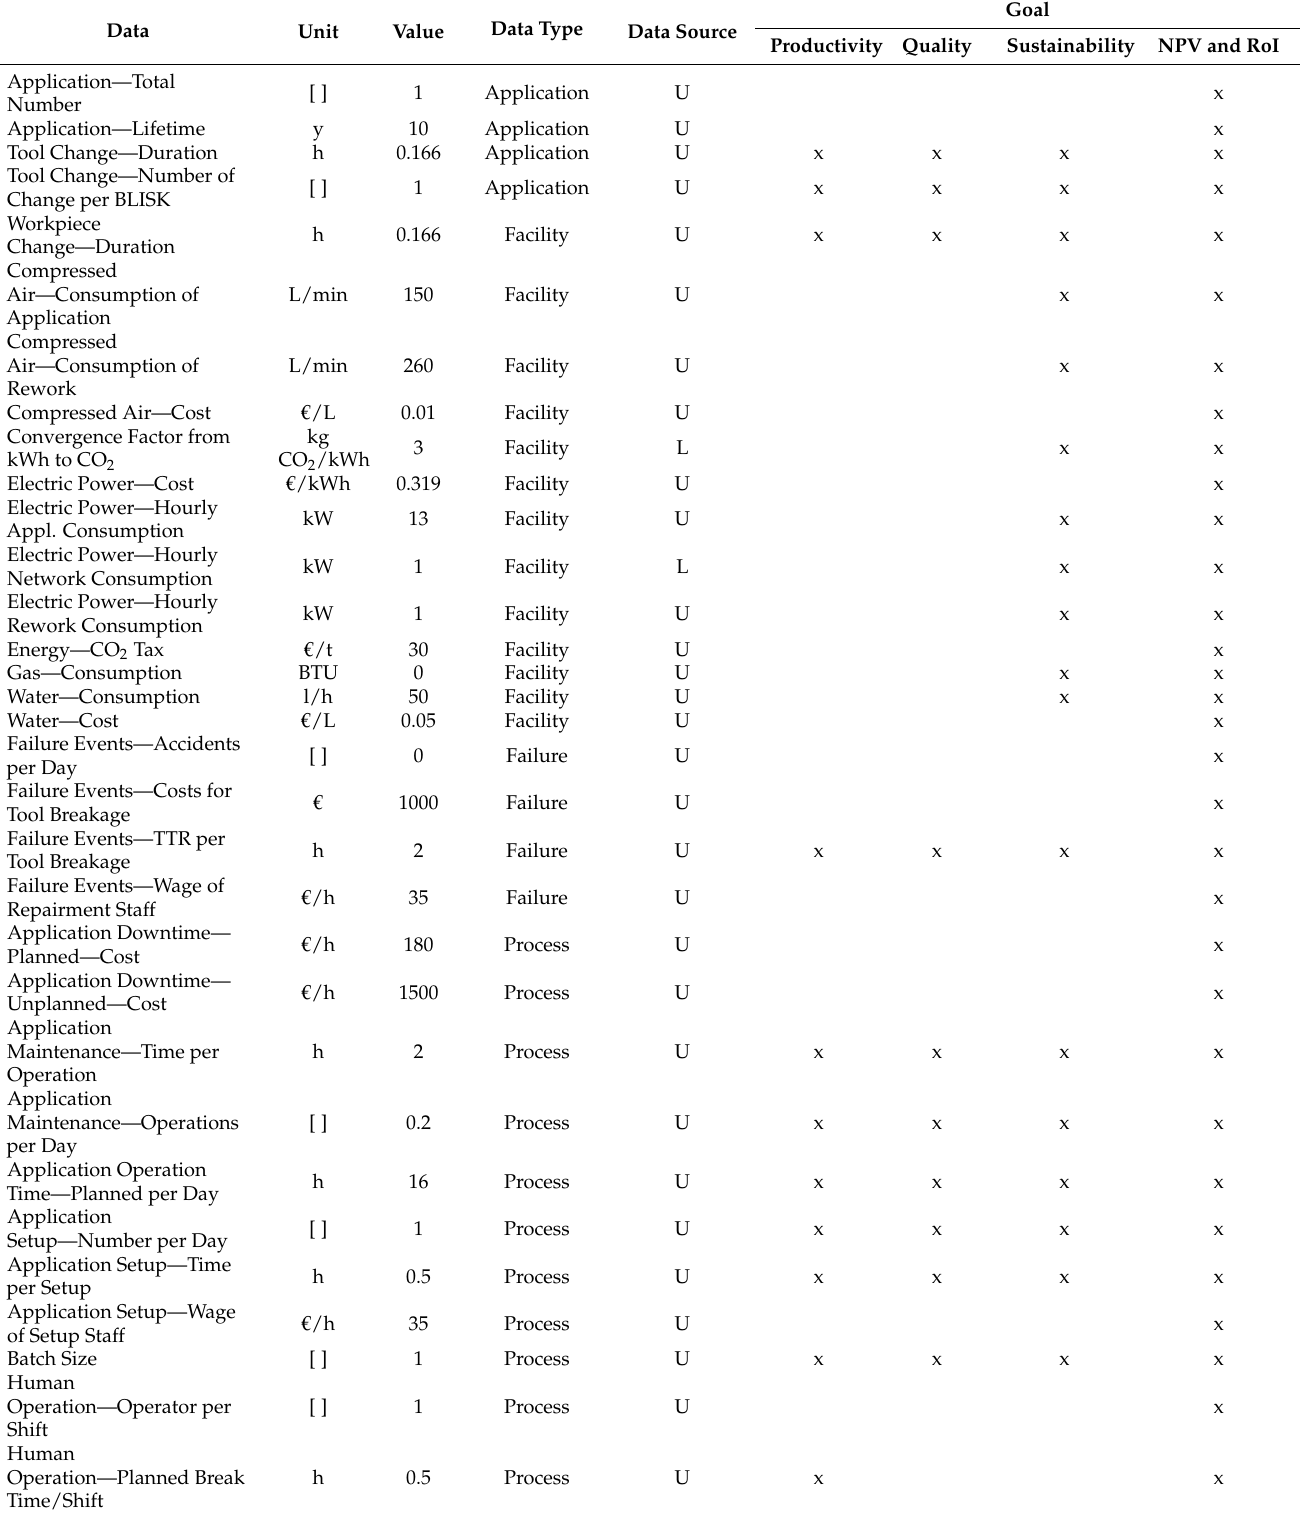
Table A1. List of formula